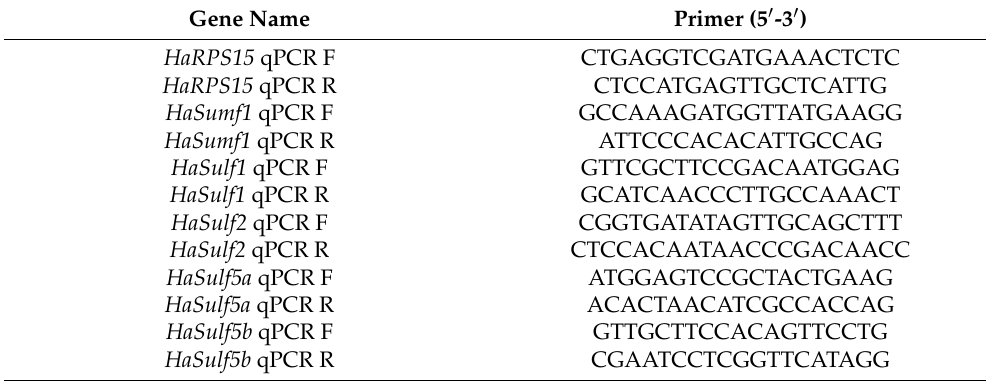
Table 1. The primers used for